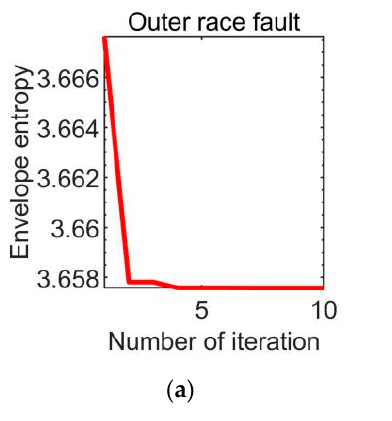
Figure 5. The time domain waveforms of vibration signals under four bearing states.